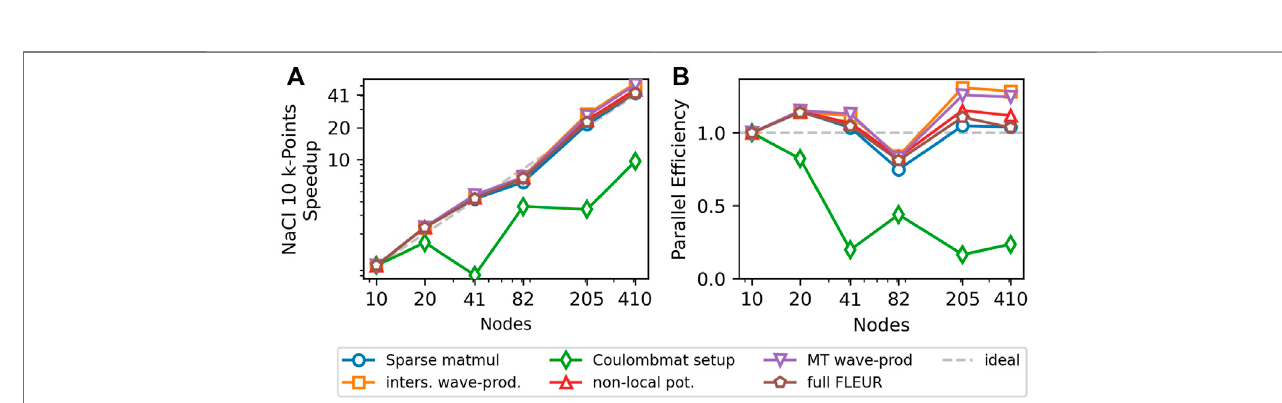
FIGURE 3 | Scaling behavior of systems with a single k -point on two types of architectures. Panels (A) and (B) show scaling of a 99-atom FeO supercell with a vacancy defect on the CPU-based SuperMUC-NG supercomputer, while (C) and (D) show the scaling behavior of a 120-atom GaAs supercell with an Al defect on JURECA ’ s GPU partition. Panels (A) and (C) show the speedup, while (B) and (D) show the corresponding parallel ef fi ciency.